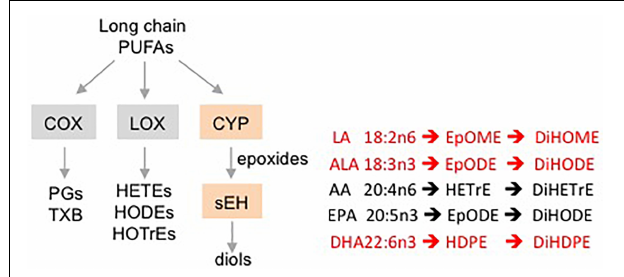
FIGURE 1 | Schematic showing different pathways for metabolizing PUFAs to oxylipins. Examples of oxylipins generated by each of the three pathways metabolizing long chain PUFAs. Shaded boxes, enzymes. Pathways affected (orange, red text) or not affected (gray, black text) by DMSO in this